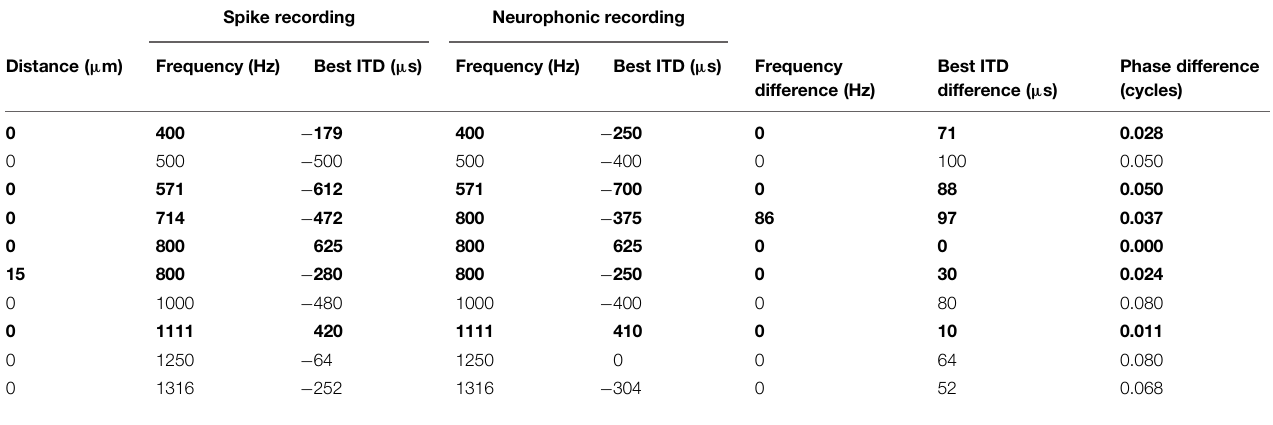
TABLE 1 | Comparison of neurophonic and spike recordings (single units shown bold) obtained in close proximity. Spike